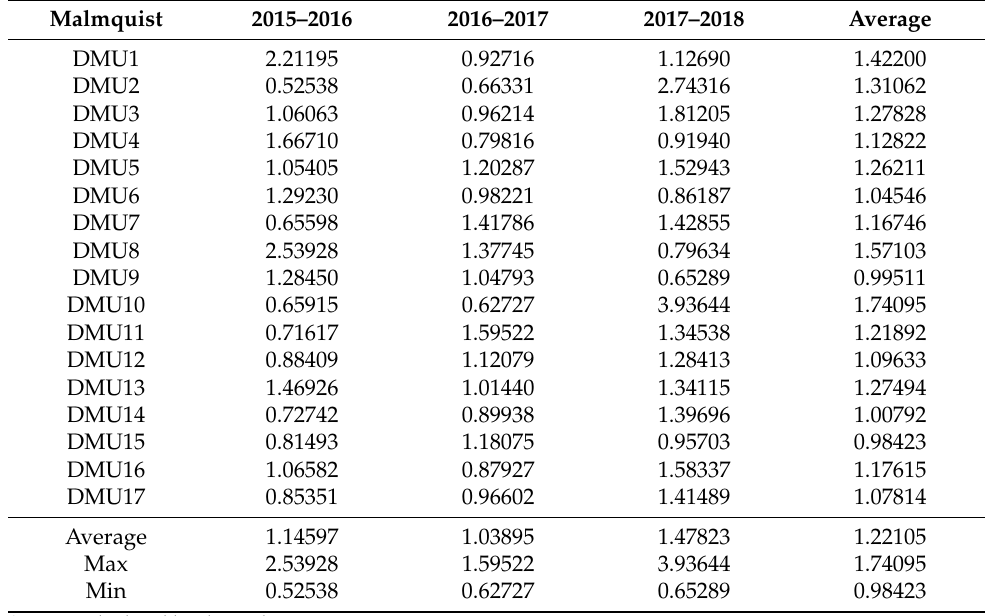
Table 8. Malmquist index (total productivity change).